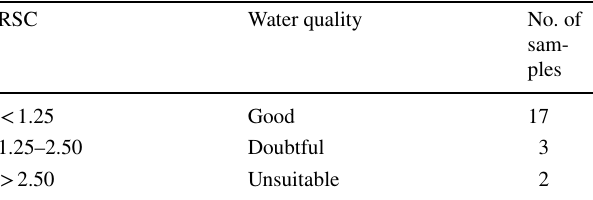
Table 8 Classification of irrigation water based on residual sodium carbonate (Eaton 1950; Wilcox et al.